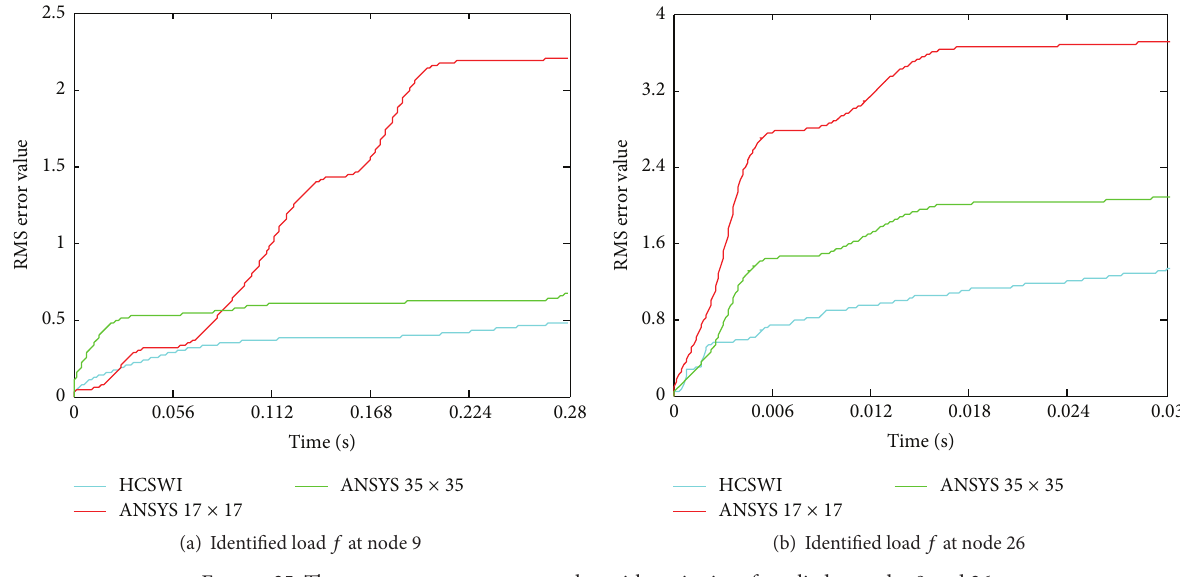
Figure 25: The root mean square error value with excitation 𝑓 applied at nodes 9 and